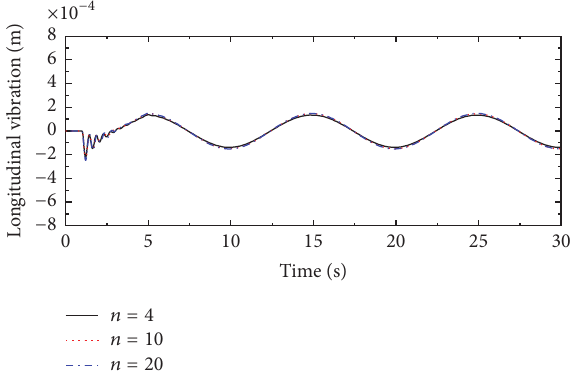
Figure 5: Longitudinal response with different numbers of modes.